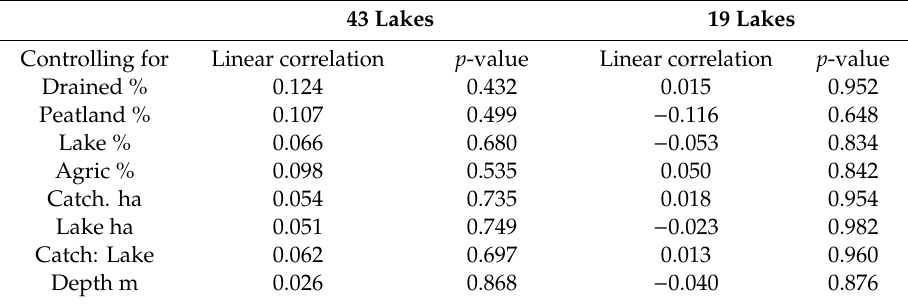
Table 4. Partial linear correlations and the associated p-values of peat extraction percentage with carbon accumulation after controlling for other variables for the full 43-lake set (left) and the 19-lake trimmed subset (right).